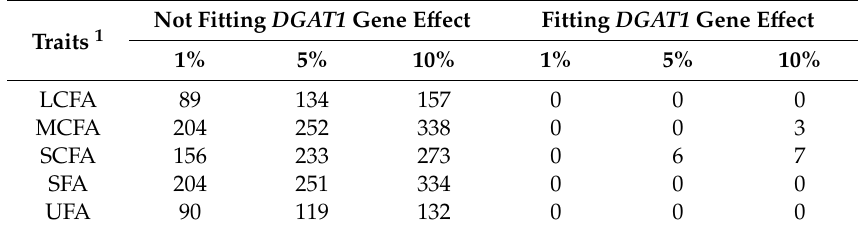
Table 1. Number of significant single nucleotide polymorphisms (chromosome-wide FDR = 1%, 5% and 10%) for the di ff erent groups of milk fatty acids, fitting or not the DGAT1 gene in the statistical